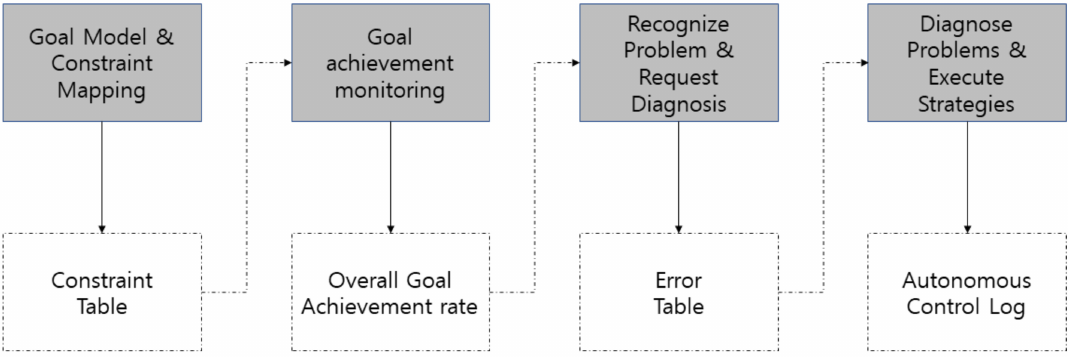
Figure 2. Autonomous control